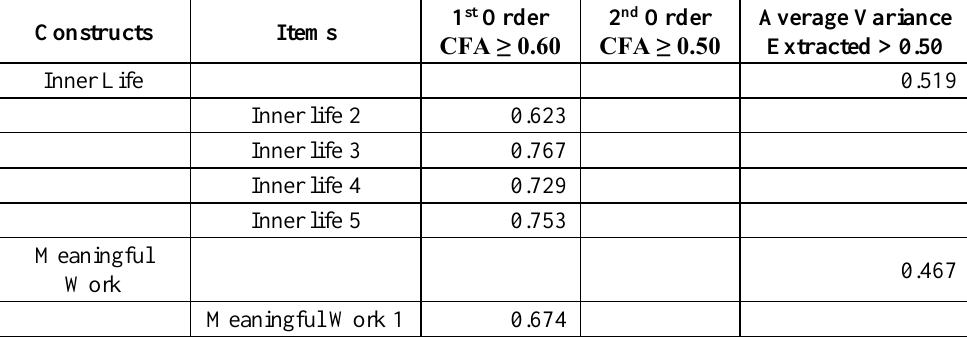
Table 1. CFA of the Items and Constructs Used in the Present Study